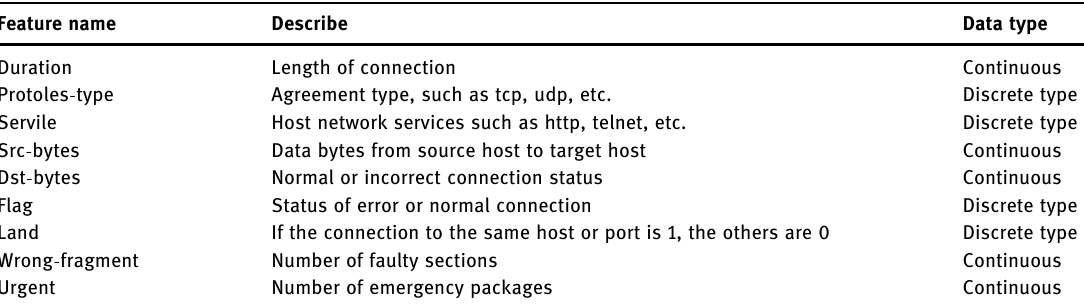
Table 1: Basic characteristics table